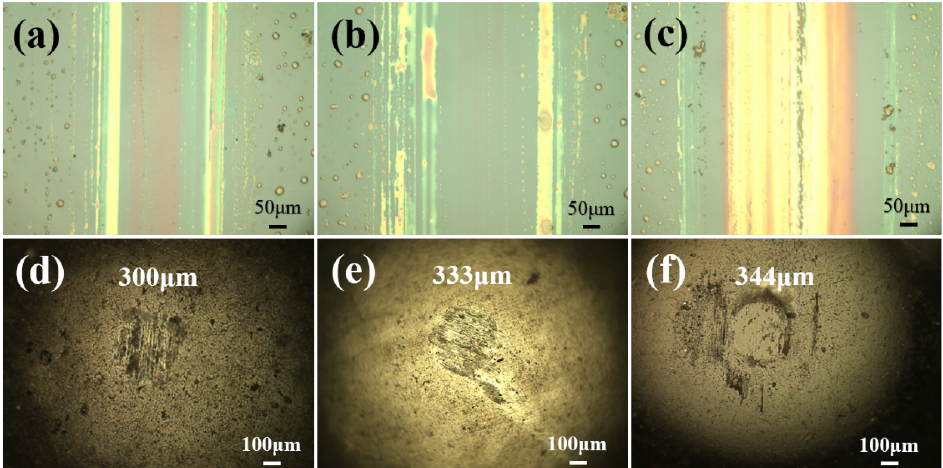
Figure 5. The worn morphology of the IL/M composite films and steel balls: IL/0.3M ( a , d ), IL/0.5M ( b , e ), and IL/1M ( c , f ).